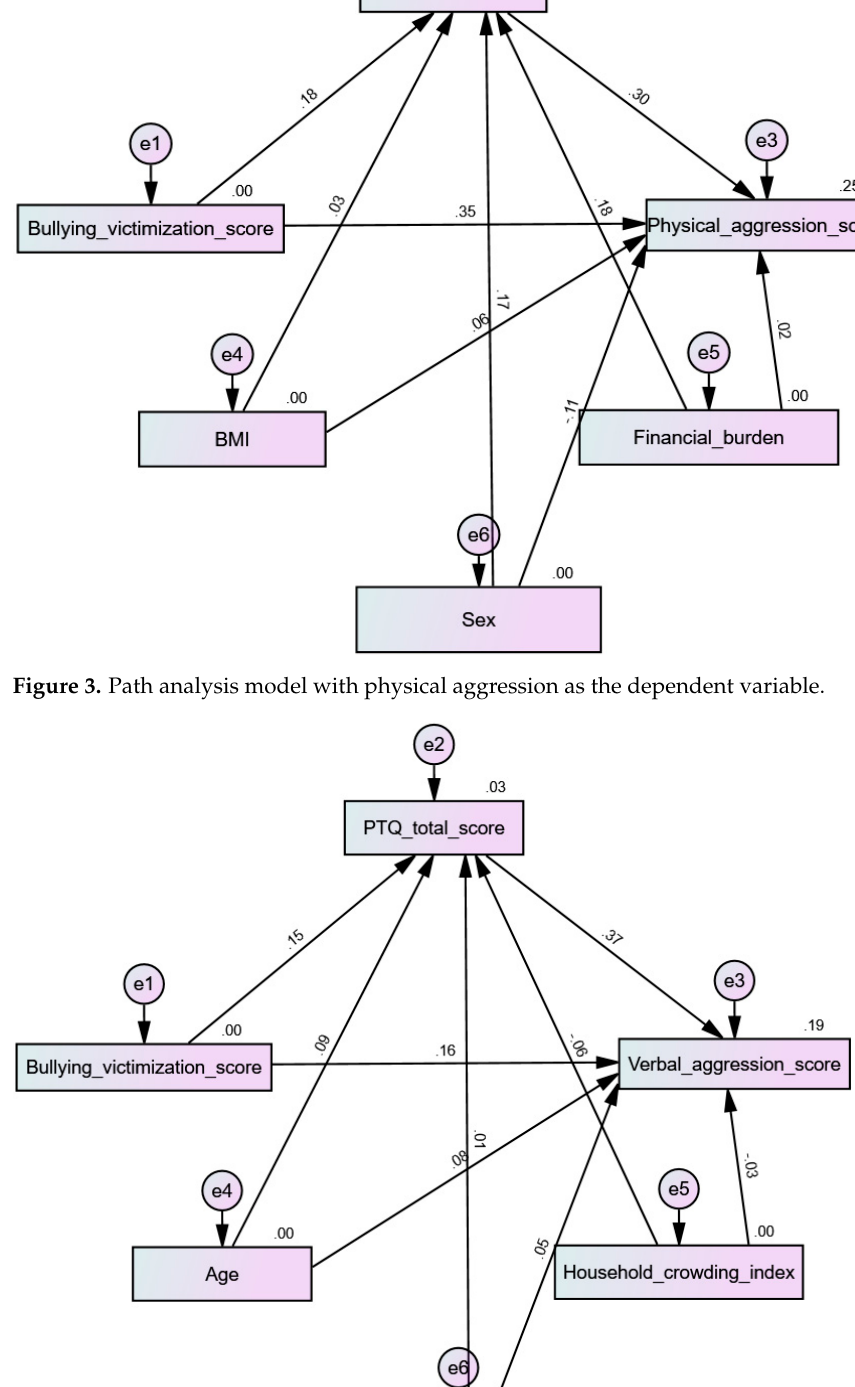
Figure 4. Path analysis model with verbal aggression as the dependent